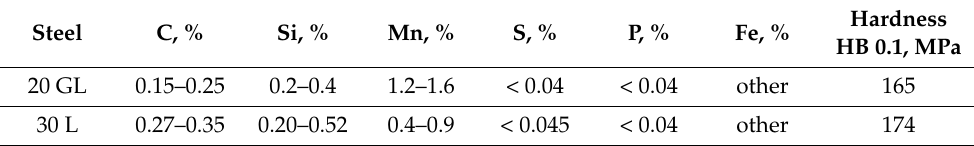
Table 5. Chemical composition and hardness of steels 20 GL and 30